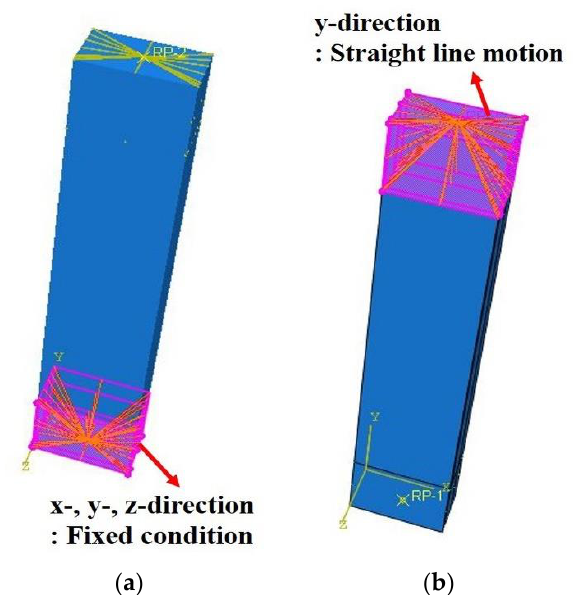
Figure 2. ( a ) Boundary and ( b ) loading conditions of the tensile test specimen during the simulation.